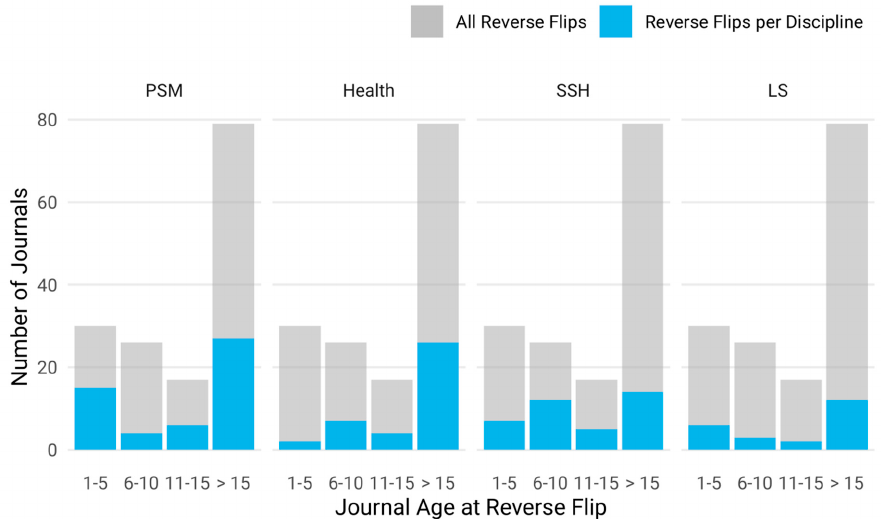
Figure 10. Discipline by journal age at the time of the reverse flip, shown as the proportion of the total number of reverse-flip journals in the dataset. The colored areas represent the distribution of journals per discipline: Physical Sciences and Mathematics (PSM), Health Sciences (Health), Social Sciences and Humanities (SSH), Life Sciences (LS).